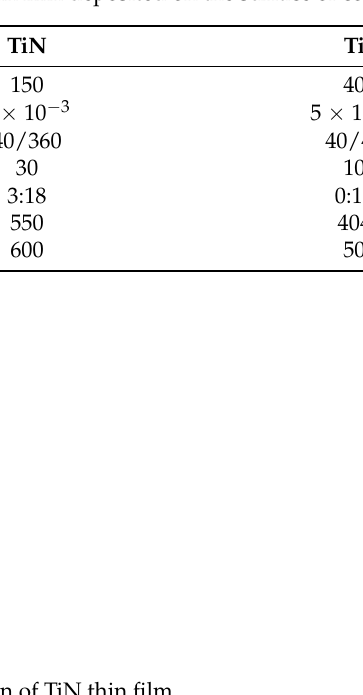
Table 1. Information of TiN and Ti adhesion thin film deposited on the surface of cold-sprayed Ti.